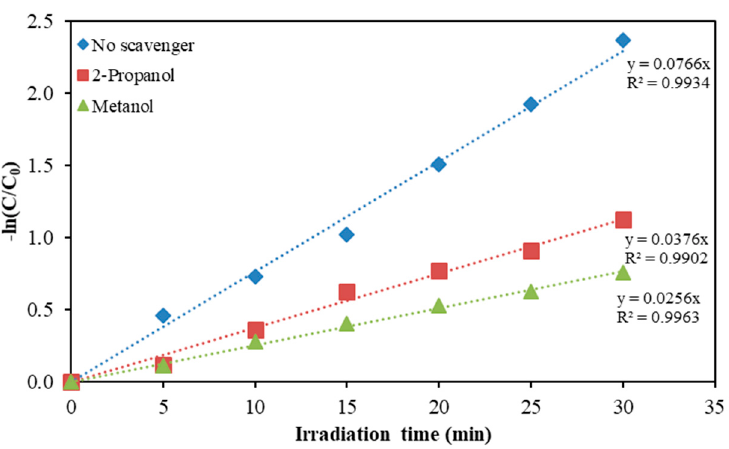
Figure 6. Photocatalytic degradation kinetics of the target molecule in the absence and presence of the selected chemical scavengers (0.1 M). Initial clofibric acid concentration of 1.5 mg/L, 1 g/L catalyst load, 9.52 mW/cm 2 , room temperature.